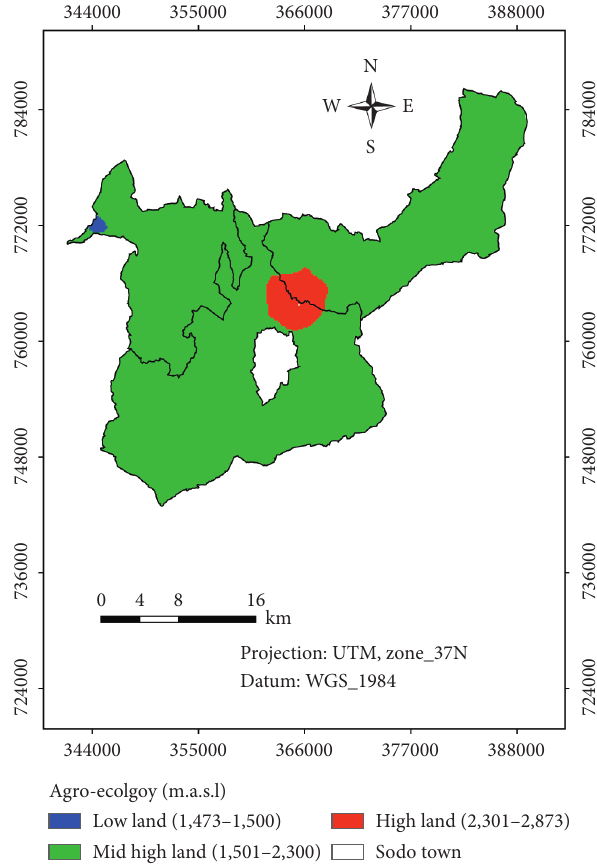
Figure 2: Agroecology of the study